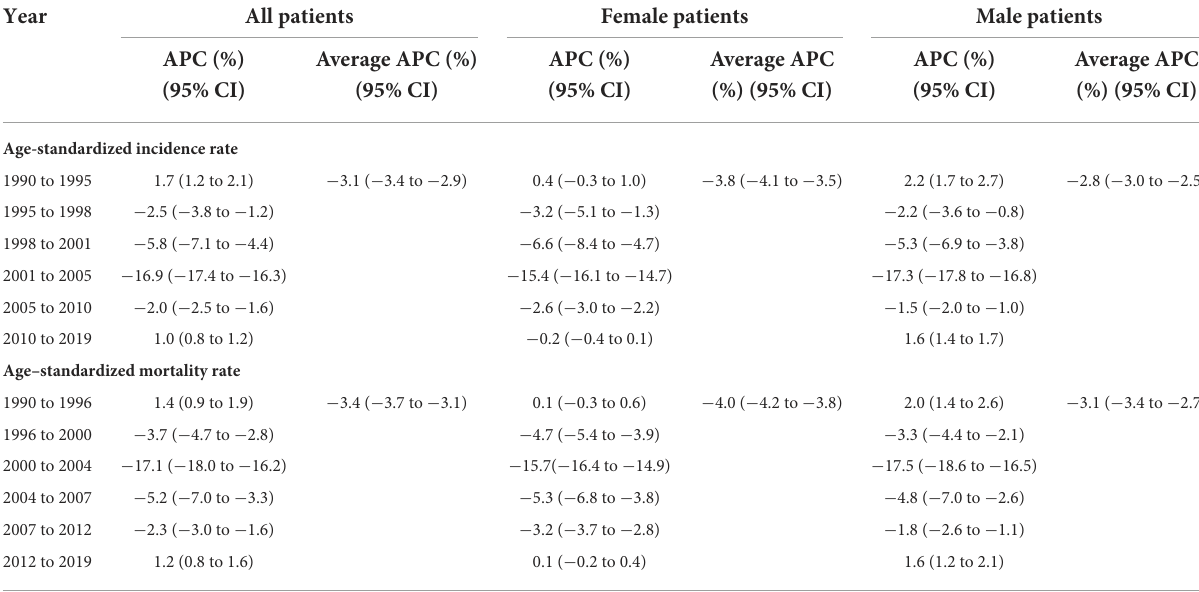
TABLE 2 Temporal trend of LC incidence and mortality from 1990 to 2019 in China. All patients Female patients